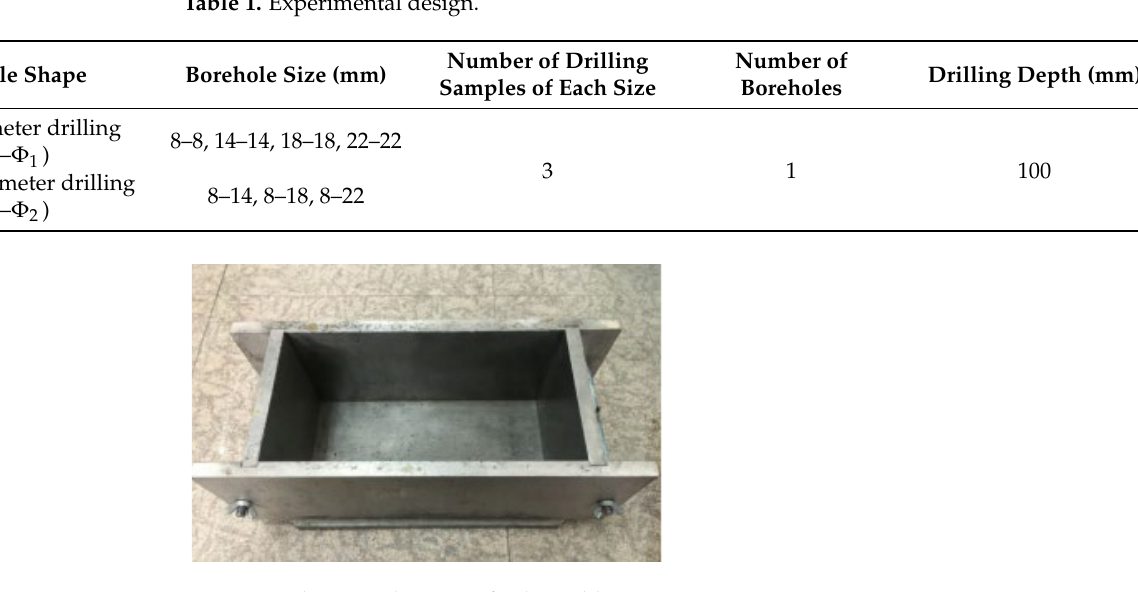
Figure 1. Schematic diagram of the test sample. Table 1. Experimental design.